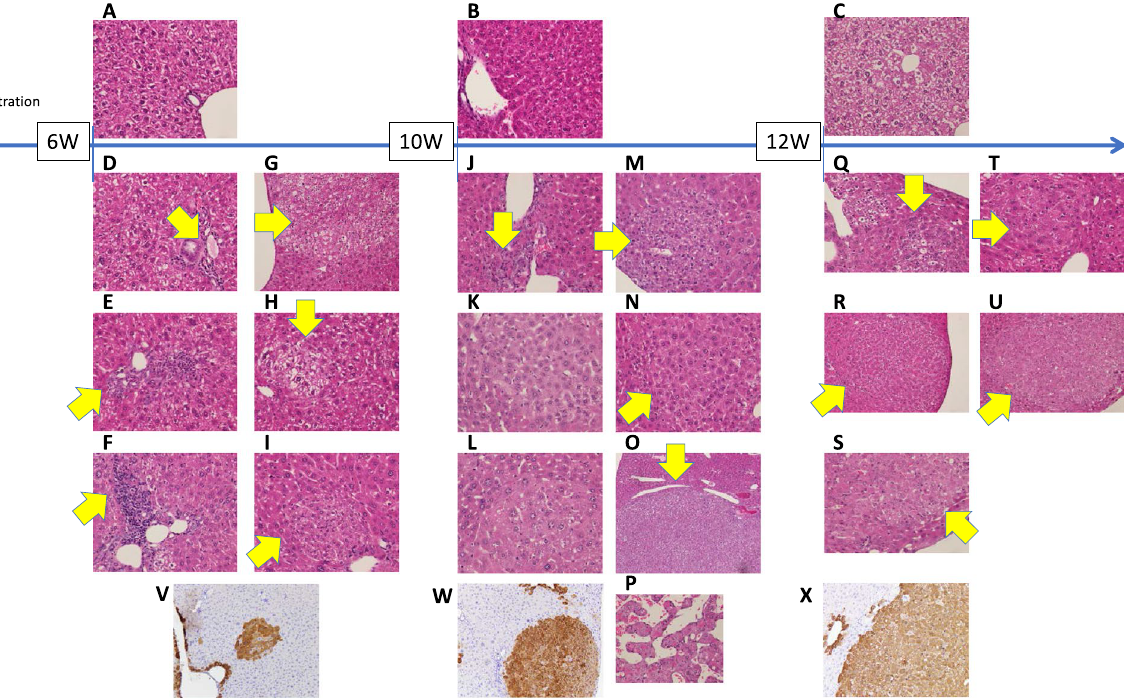
Figure 1. Changes in histopathology with the course of hepatocarcinogenesis. Histopathological images were evaluated by HE staining and glutamine synthetase (GS) immunostaining. Normal hepatic histology without any inflammatory changes in CTL-mice at 6 W ( A ), 10 W ( B ), and 12 W ( C ). STZ-mice (6 W) ( D – I , V ): Hepatocyte degeneration is seen mildly in the background ( D – I ), and mild portal infiltration of lymphocytes ( D , F ) and bile ductular hyperplasia ( E ) are observed. Small clusters of atypical hepatocytes showing mild nuclear atypia with hydropic cytoplasmic change (< 1 mm in size) were observed ( G – I ). GS is diffusely positive in these atypical hepatocytes ( V ). STZ-mice (10 W) ( J – P , W ): Hepatocyte degeneration is mildly observed in the background ( J – L ). Infiltration of lymphocytes and hyperplasia of bile ductules are scatteredly observed ( J – L ). Aypical hepatocellular nodules (1–6 mm in size) ( M – O ) those resembling low–high grade dysplastic nodules and HCC showing thin trabecular pattern with cellular atypia ( P ) are observed. GS is diffusely positive in these atypical hepatocellular nodules and HCC ( W ). STZ-mice (12 W) ( Q – U , X ): In the background liver, degeneration of hepatocytes, infiltration of lymphocytes, and hyperplasia of bile ductules were slightly